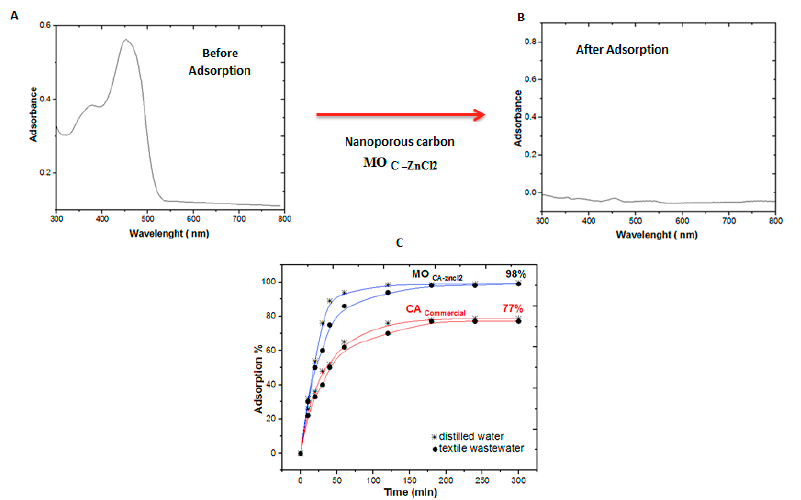
Figure 5. UV-vis spectrophotometer spectra of the dyeing effluent. ( A ) Before adsorption ( B ) After adsorption, ( C ) Comparative adsorption of MO C-ZnCl2 nanoporous carbon vs. commercial activated carbon for MeO adsorption . carbon for MeO